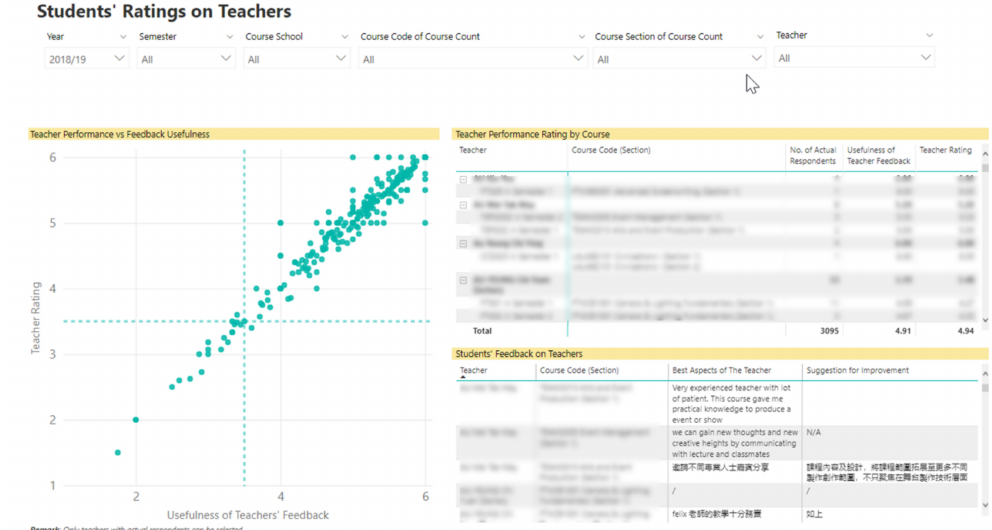
Figure 10. Students’ Ratings of Teachers. Note: (1) In the visual “Teach Performance vs. Feedback Usefulness”, each data point represents the average rating given by students to a teacher and the question “The teacher provided me with a helpful feedback” for a particular course. (2) The English explanation of the Chinese-‘ 邀 請 不 同 的 專 業 人 士 嘉 賓 分 享 ’ is ‘Invite different professionals to share their experience’. (3) The English explanation of the Chinese-‘ 課 程 內 容 及 設計 , 將 課 程 範 圍 拓 展 至 更 多 不 同 製 作 創 作 範 圍 , 不 只 聚 集 再 舞 臺 製 作 技 術 層 面 ’ is ‘For the course design, please extend the content scope to more diverse production creation areas, no limited in the stage production’. (4) The English explanation of the Chinese-‘ 老 師 的 教 學 十 分務 實 ’ is ‘The course content is very practical’. (5) The English explanation of the Chinese-‘ 如 上 ’ is ‘Same as above’.